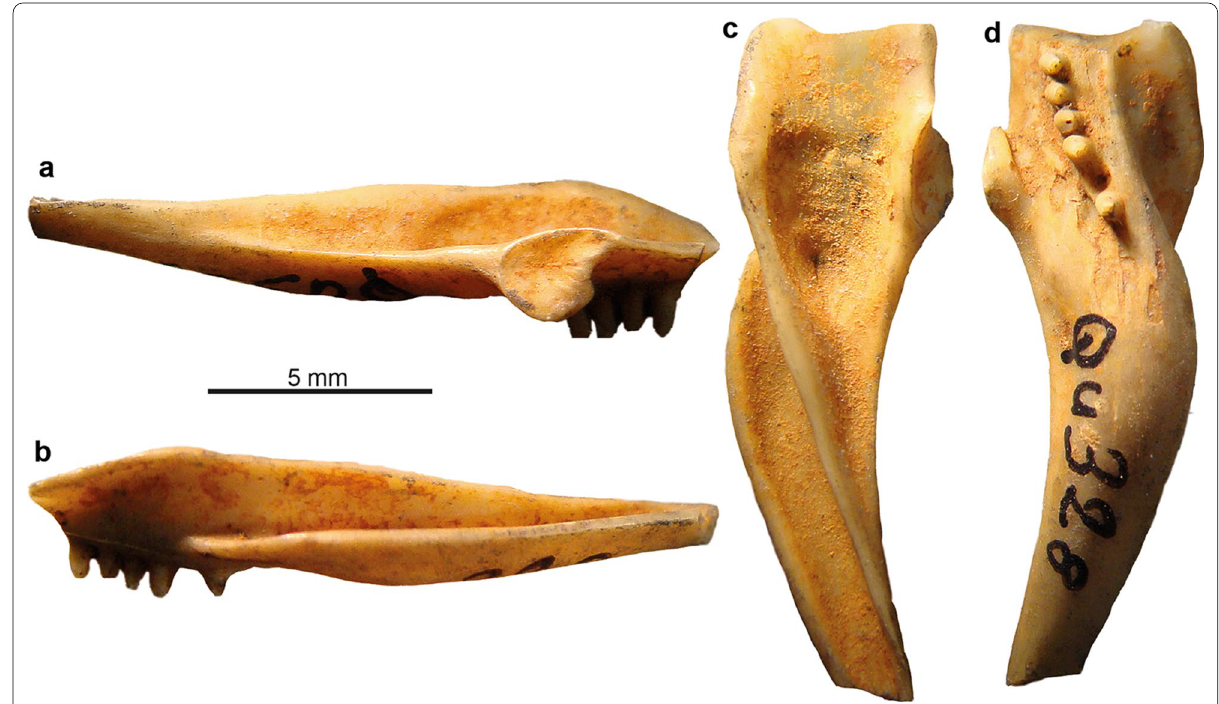
Fig. 112 Paralectotype right pterygoid (MNHN.F QU16328) of Paleryx cayluxi in labial ( a ), medial ( b ), dorsal ( c ), and ventral ( d )